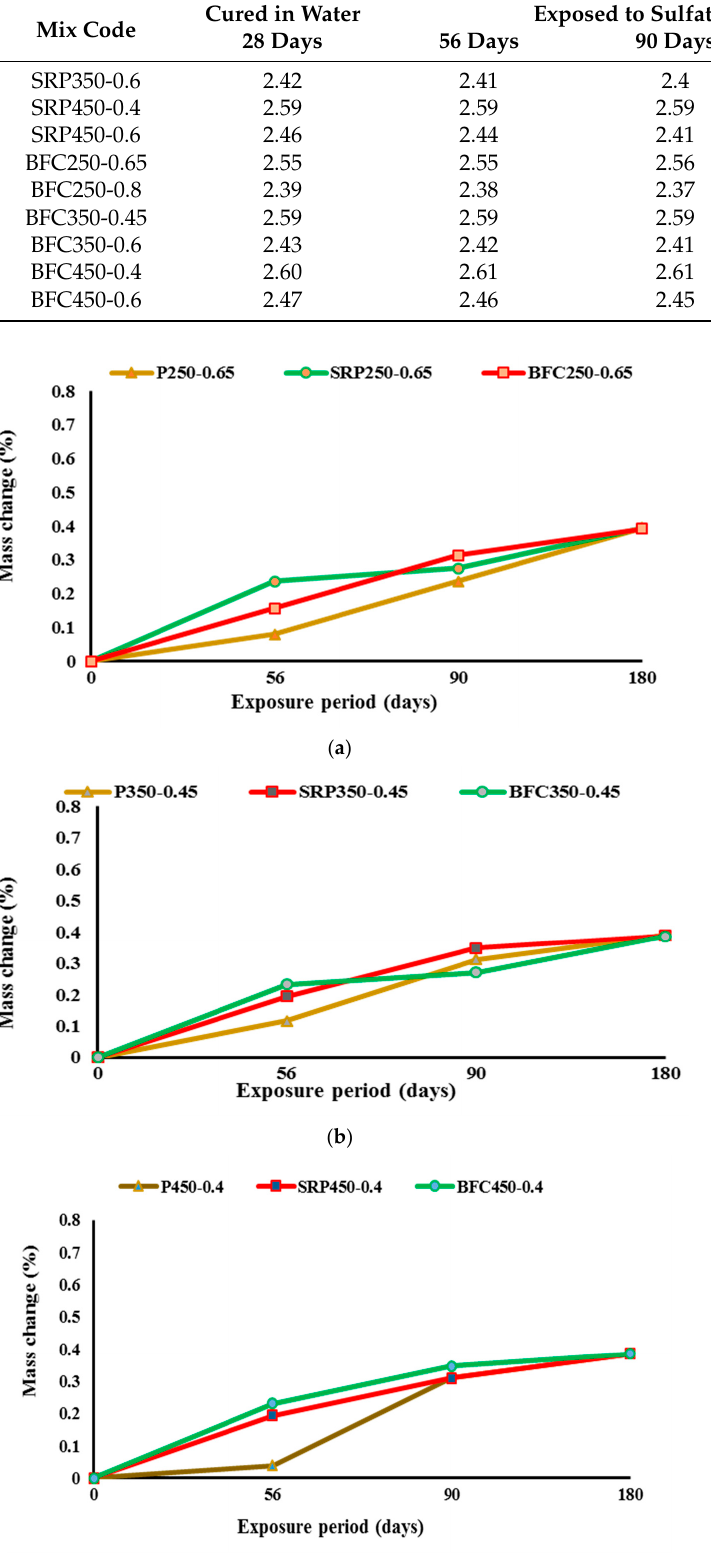
Figure 7. Mass changes for mixes with low w/b ratios: ( a ) low strength concrete, ( b ) medium strength concrete, and ( c ) high strength concrete.